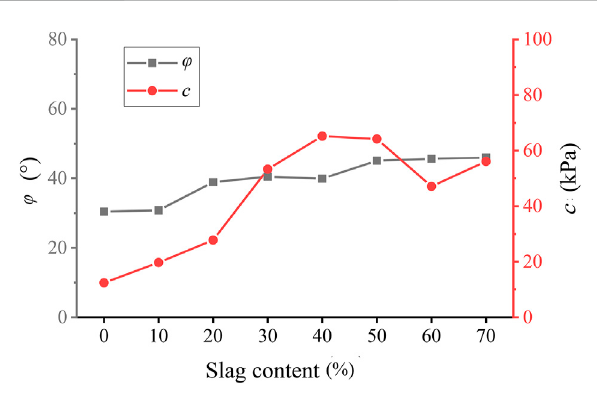
FIGURE 3 The shear strength parameters of TSM varying with slag